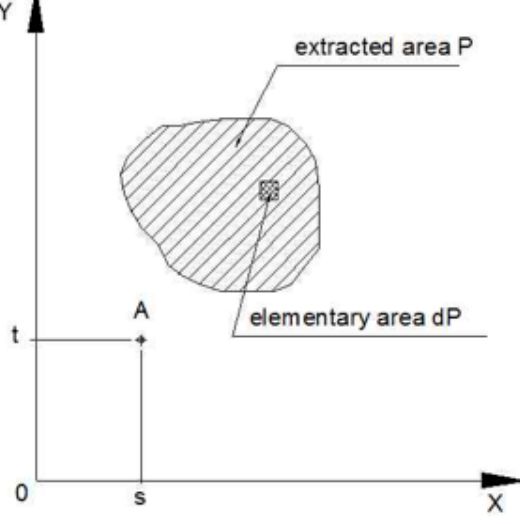
Figure 2. Schematic location of point A ( s , t ) and the extracted area.